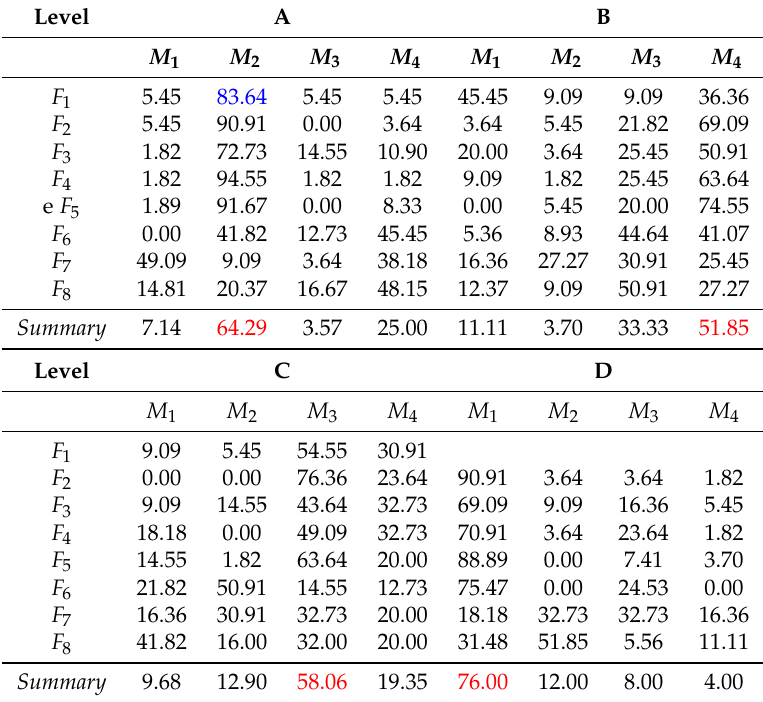
Table 4. The human test on 55 valid subjects with four different methods. The number are shown in percentage. The numbers marked in red indicate the proportion of method M i in levels A, B, C, D with higher percentages, and the associated methods are more representative in the